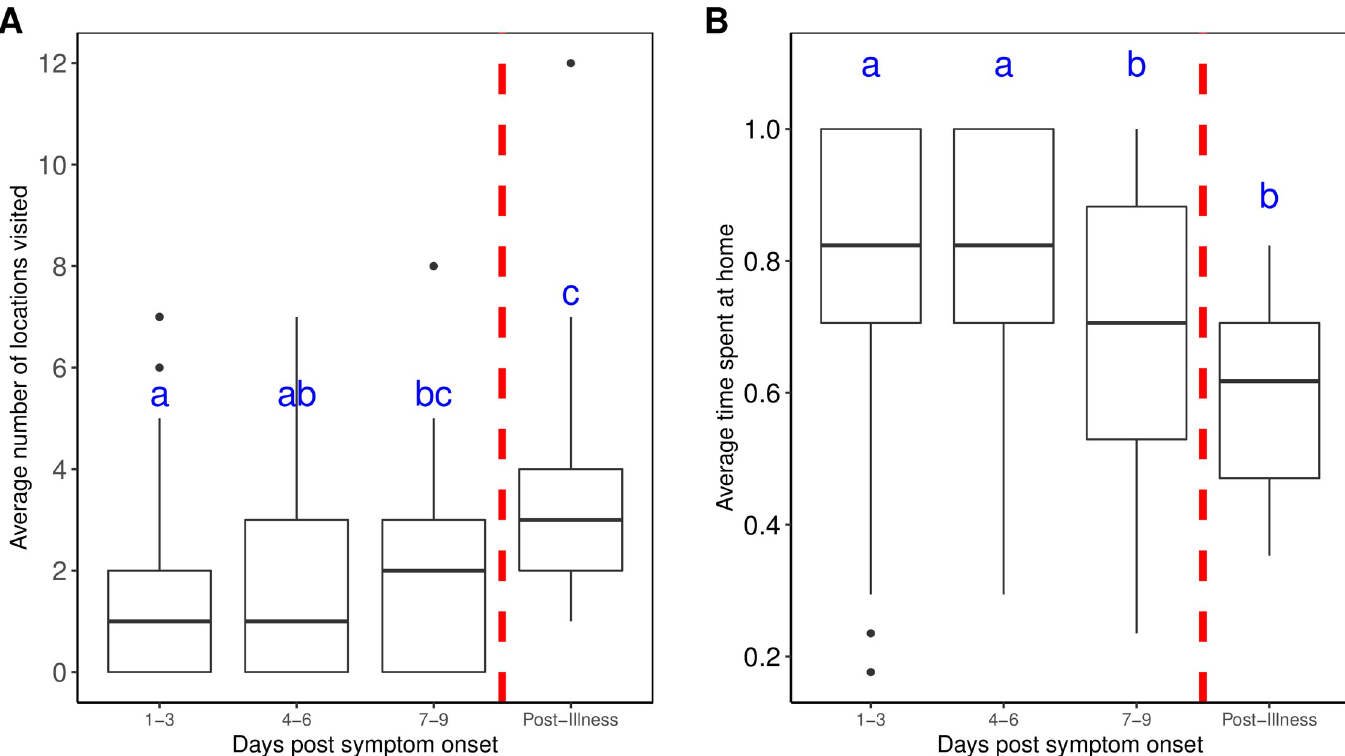
Fig 3. Mobility values during illness (in 3-day intervals). (A) Average number of locations visited per 3-day period. (B) Average proportion of time spent at home per 3-day period. Significant differences, denoted by letters, were detected using pairwise paired Wilcoxon Sign Rank tests with Bonferroni’s correction to account for a family-wise error-rate of 0.05. All significant differences had p-values <